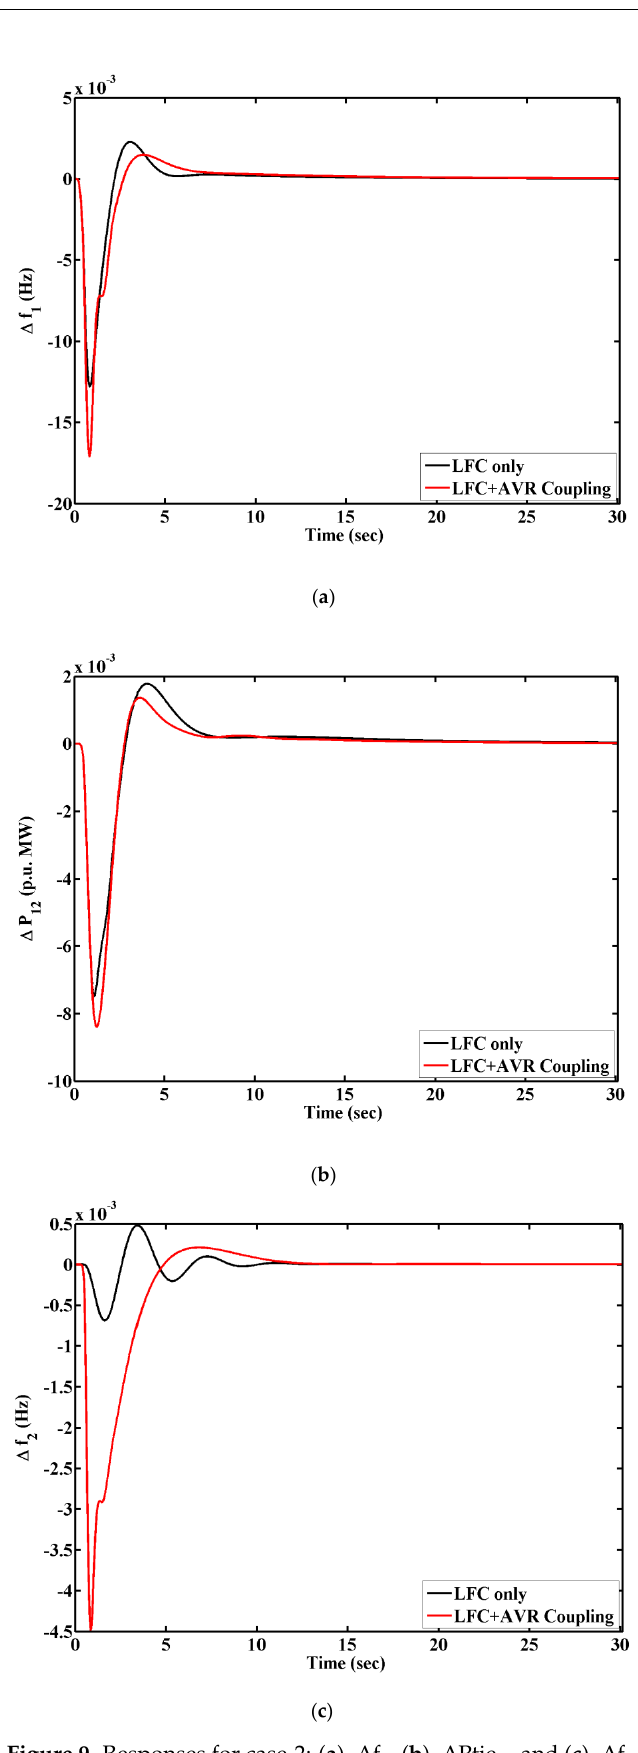
Figure 9. Responses for case-2: ( a ). ∆ f 1 , ( b ). ∆ Ptie 12 and ( c ). ∆ f 2 .